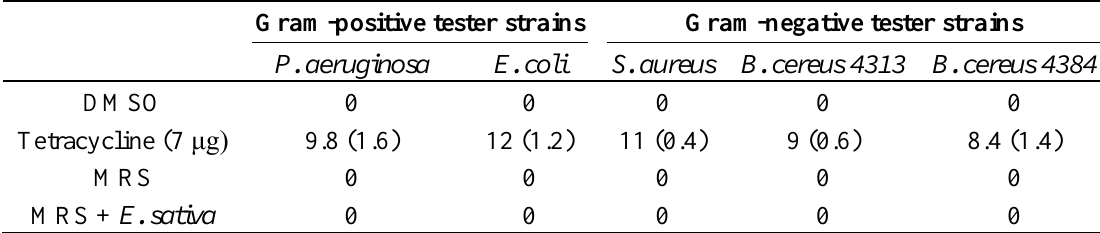
Table 5. Antimicrobial activity (evaluated through the inhibition halo test) of the filtered supernatant of MRS and MRS + E. sativa , DMSO (negative control) and tetracycline (7 µg, positive control) against Bacillus cereus 4313, Bacillus cereus 4384, Staphylococcus aureus , Escherichia coli and Pseudomonas aeruginosa .